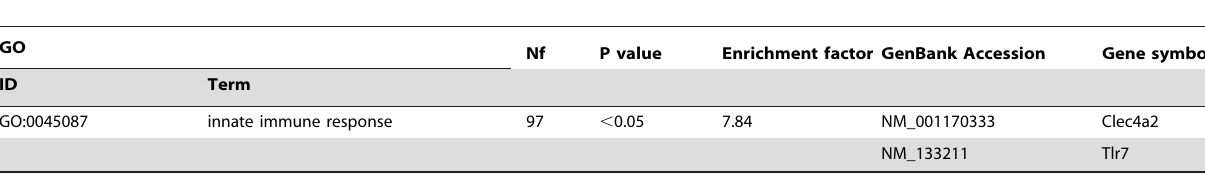
Table 6. Functional analysis of cluster C using Gene Ontology